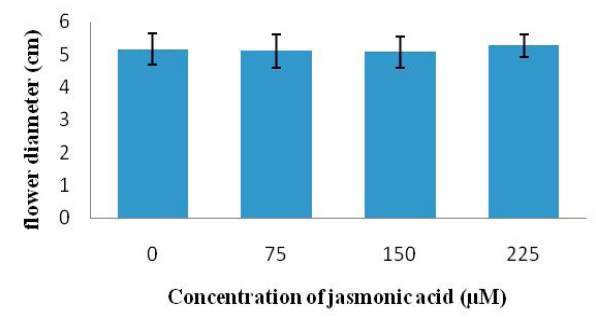
Fig. 1. Effect of different concentration of jasmonic acid on flower